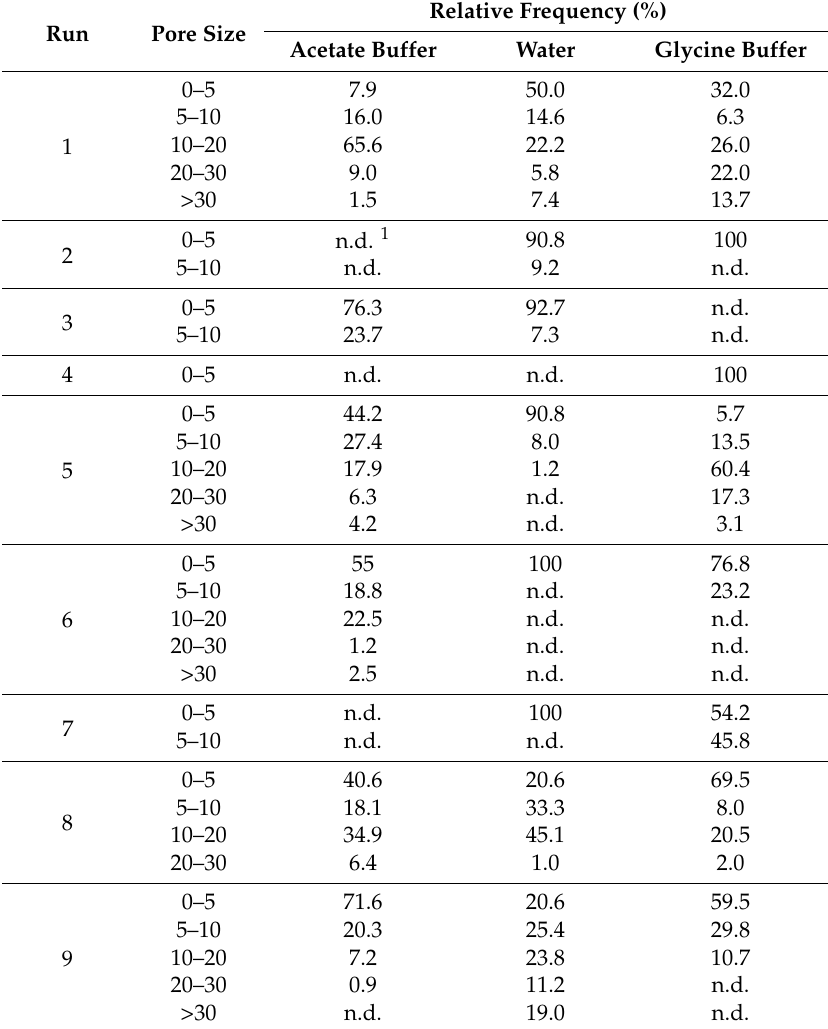
Table 3. Distribution and relative frequencies for pore size of each CGP/PVA film produced using the 3 3-1 fractional factorial